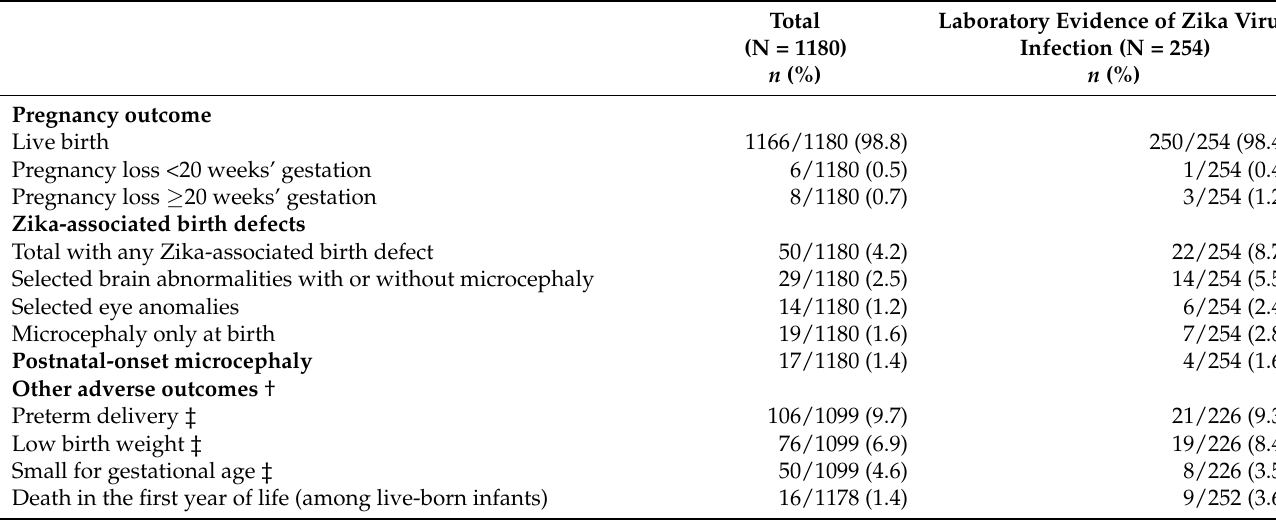
Table 2. Pregnancy and infant outcomes among pregnant women with symptoms of Zika virus disease and subset